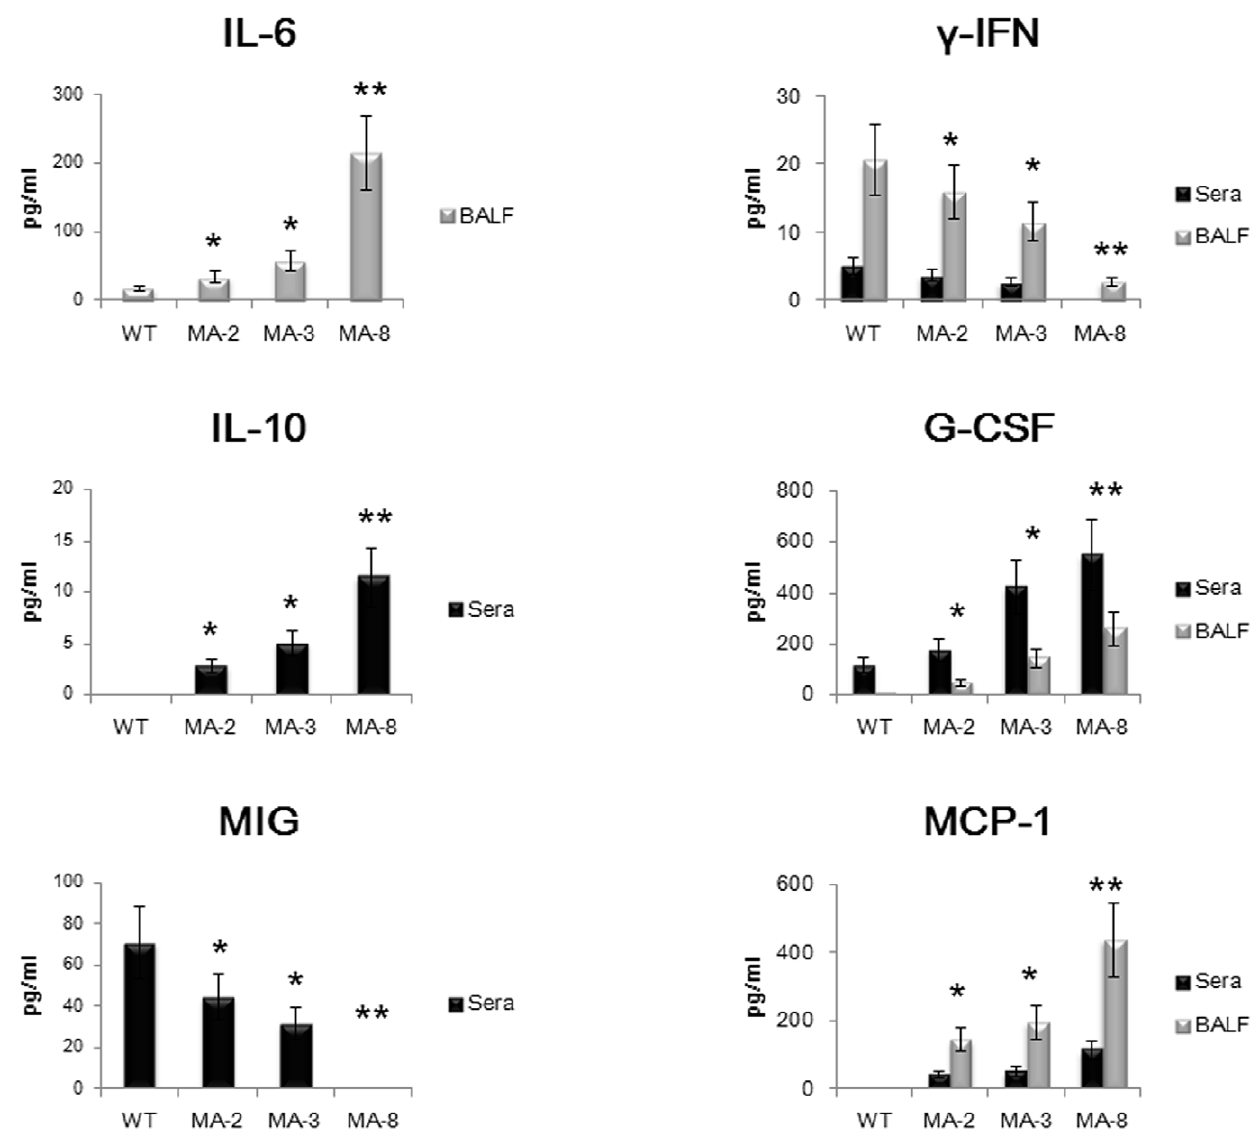
Figure 7. The cytokine and chemokine responses. The concentrations of cytokines and chemokines in BALF and sera of individual mice were measured quantitatively using Cytometric Beads Array. Data are expressed as mean 6 SD of the concentrations of individual cytokines or chemokines in BALF or sera of each group of mice (n=10 per group) from three separate experiments. There was no significant difference in the concentrations of other cytokines and chemokines tested (data no shown). * P , 0.05 and ** P , 0.01 vs. the values in the mice infected with wild type